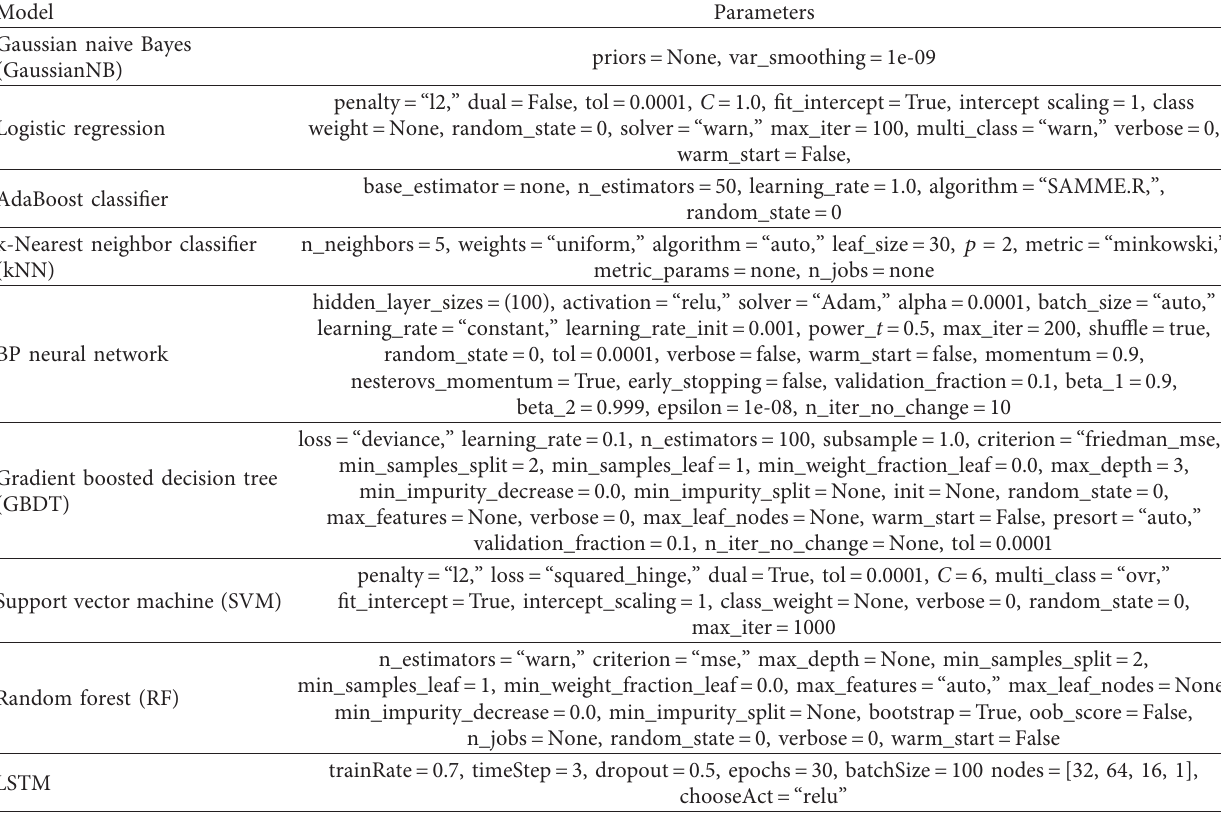
Table 4: Model parameters of the basic